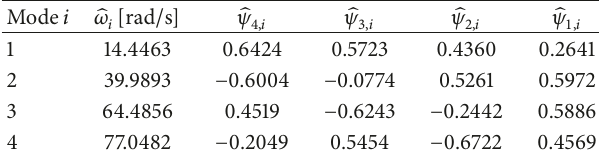
Figure 8: Accelerograms representing a white noise with Gaussian distribution (a), a nonstationary stochastic signal (b), and the modeling of an elastic shock (c). Table 2: Natural frequencies identified by the RWS-TSVD-based algorithm and singular vectors computed for the undamaged frame.